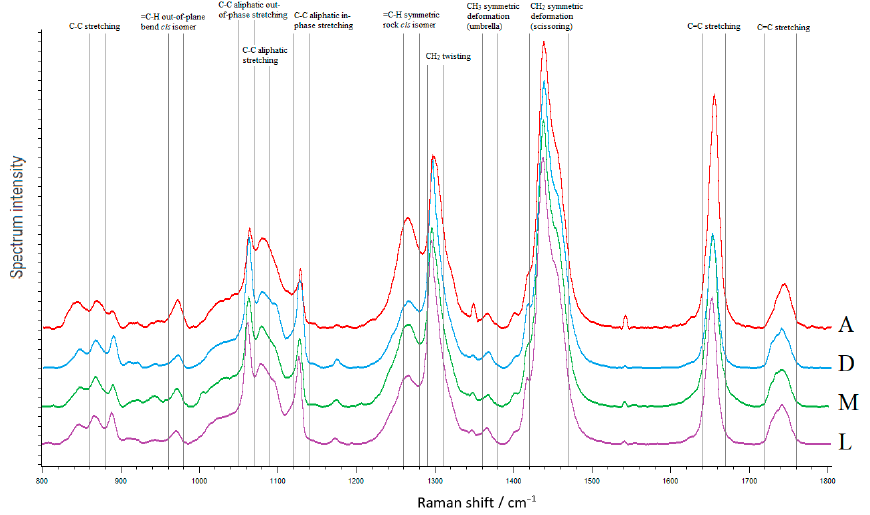
Figure 3. Raman spectra of backfat samples from four pig breeds, detection range 800 and 1800 cm − 1